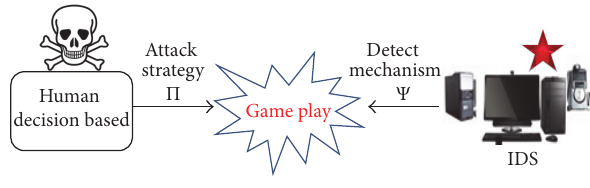
Figure 6: The game play between attacker and